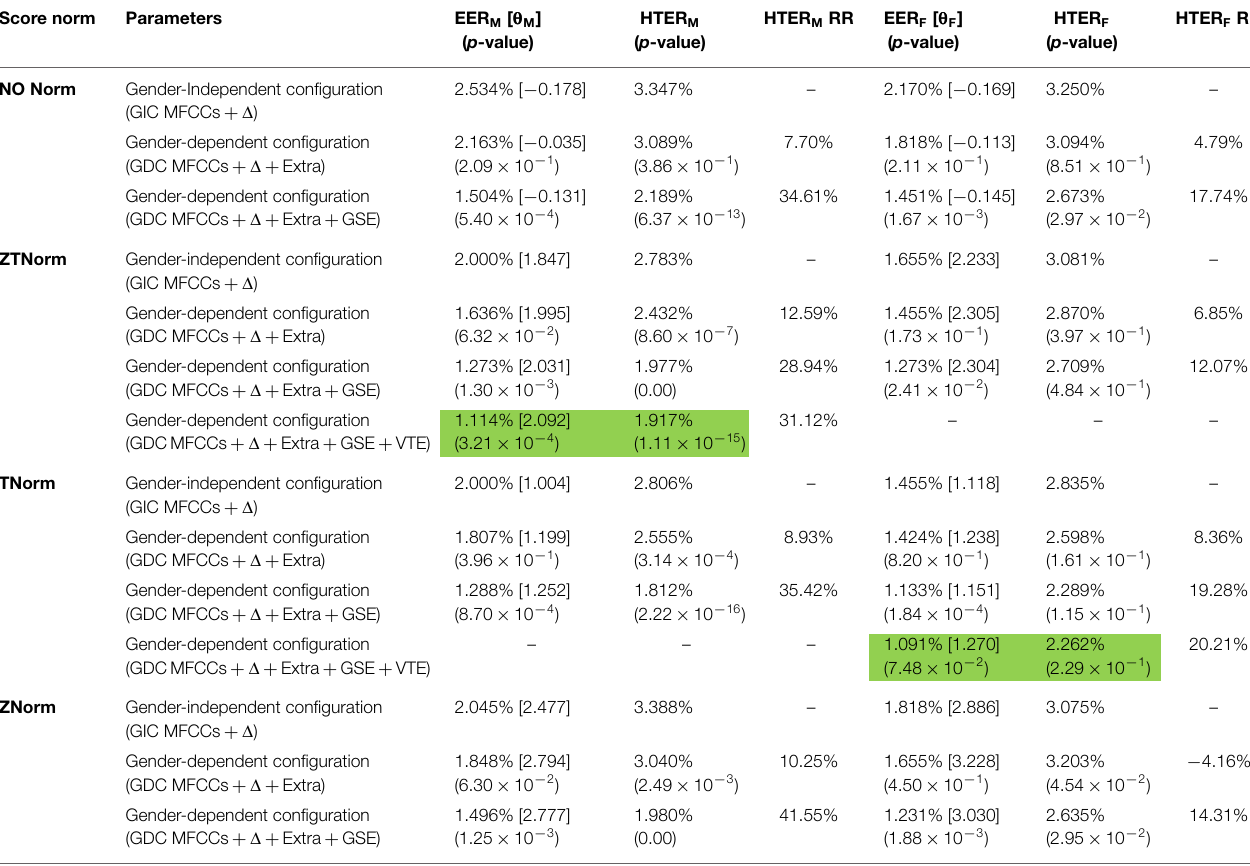
The results highlighted in green, are the ones achieving higher recognition rates.